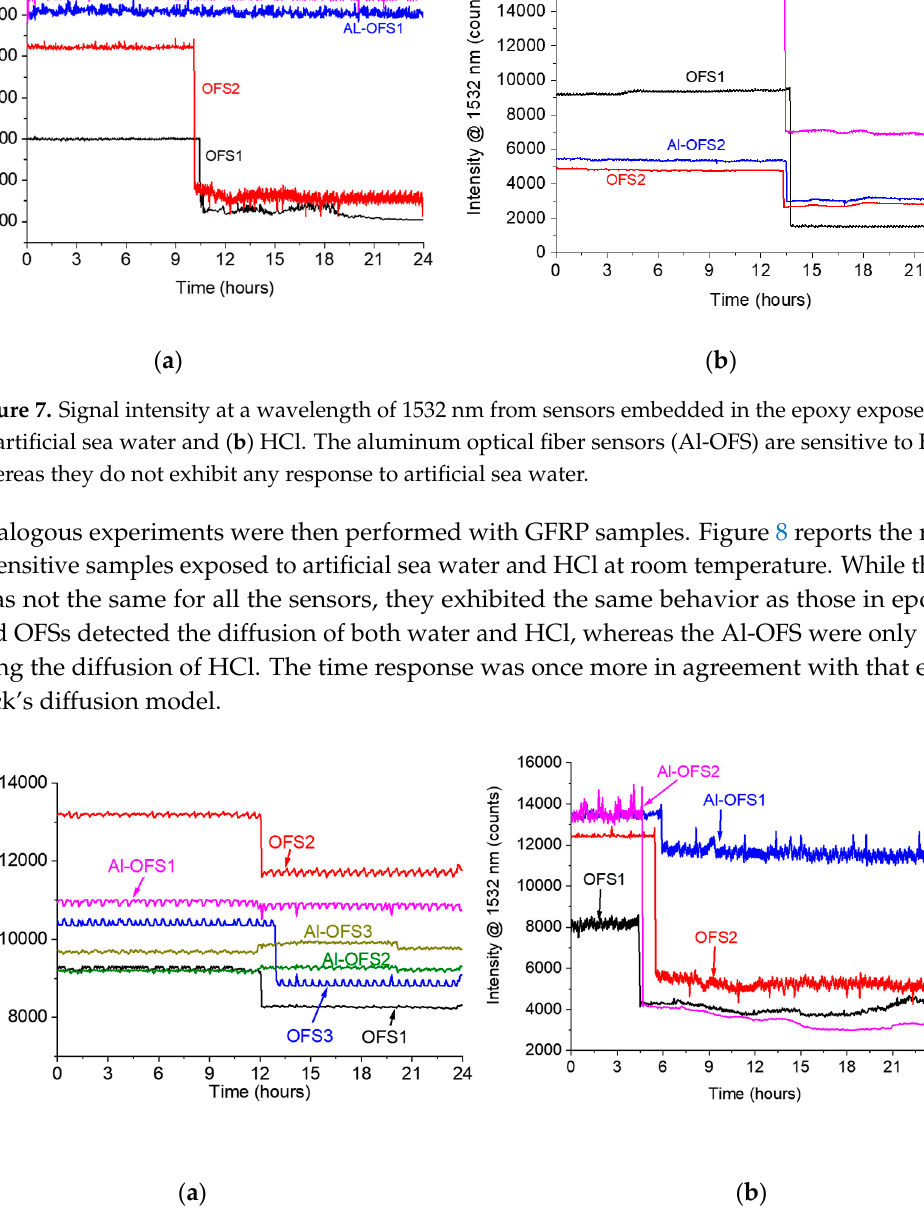
Figure 8. Signal intensity at a wavelength of 1532 nm from sensors embedded in GFRP exposed to ( a ) artificial sea water and ( b ) HCl. The Al-OFS are sensitive to HCl, whereas they do not exhibit any response to artificial sea water.